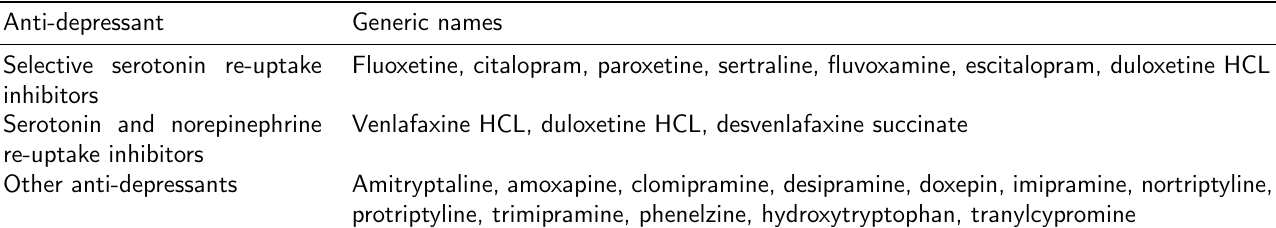
Supplementary table 1: Serotonin re-uptake inhibitors and other anti-depressants